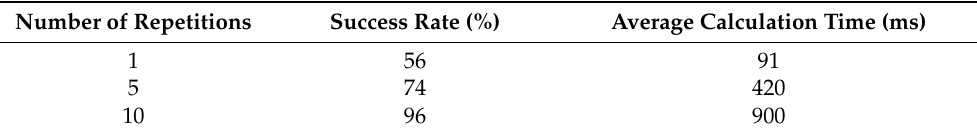
Table 1. The success rate and average calculation time for 1, 5, and 10 planning steps of the improved RRT algorithm in obtaining a “near”-optimal path.